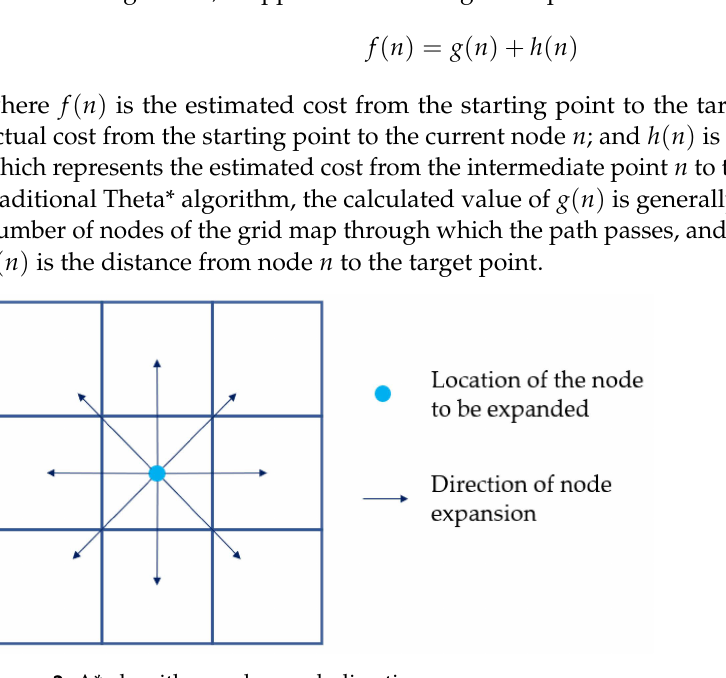
Figure 2. A* algorithm node search direction.